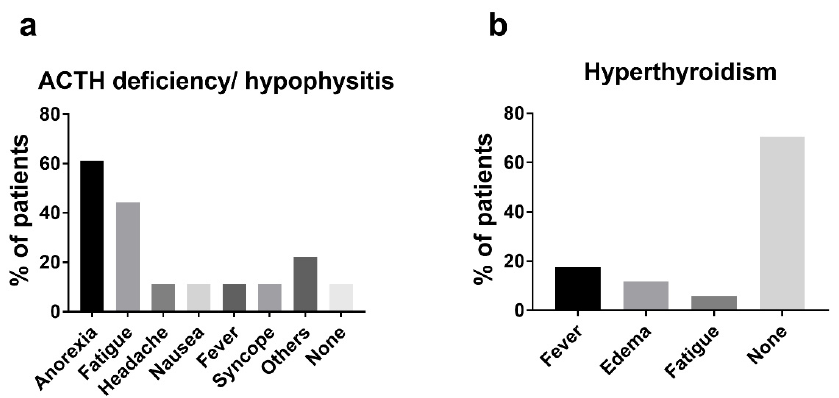
Figure 1. Symptoms in endocrine irAEs. ( a ) ACTH deficiency/ hypophysitis ( n = 18); ( b ) hyperthy- roidism ( n = 17).